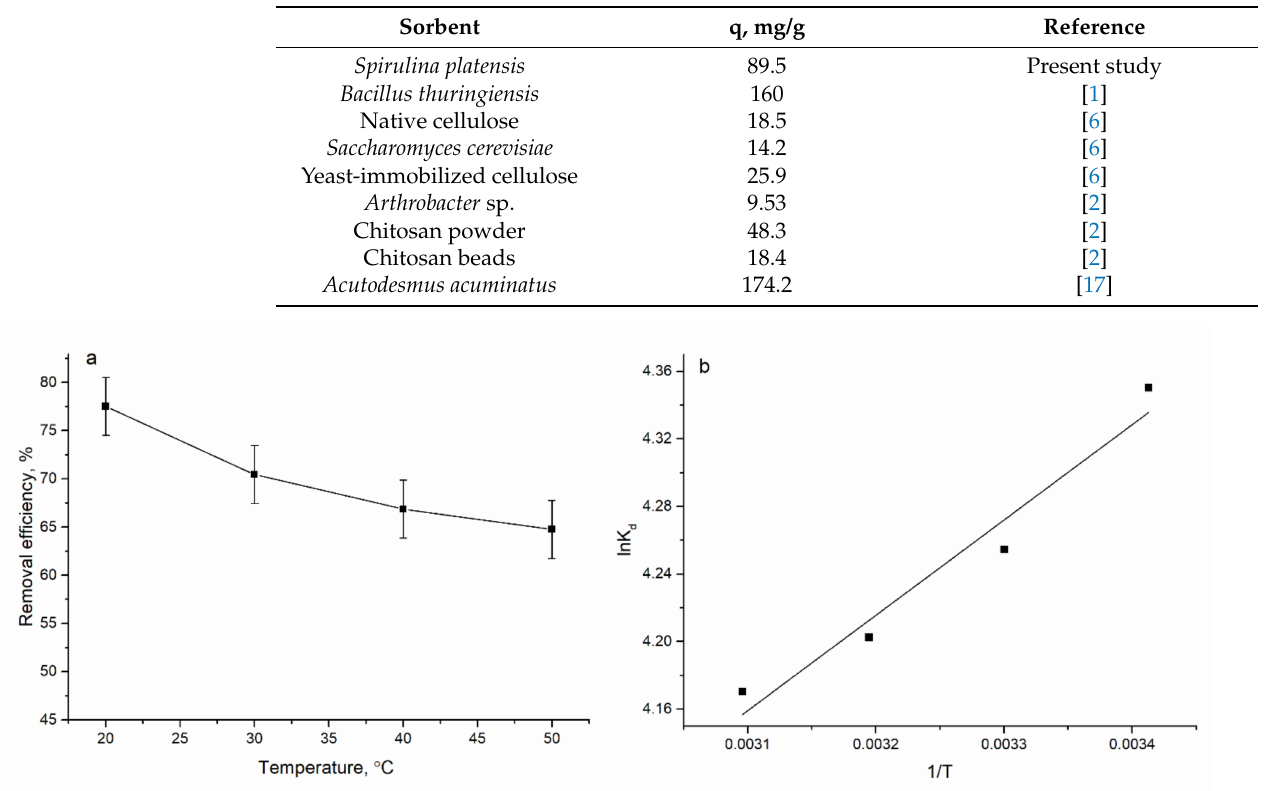
Table 3. Thermodynamics parameters for Eu(III) biosorption on A. platensis . Temperature, K